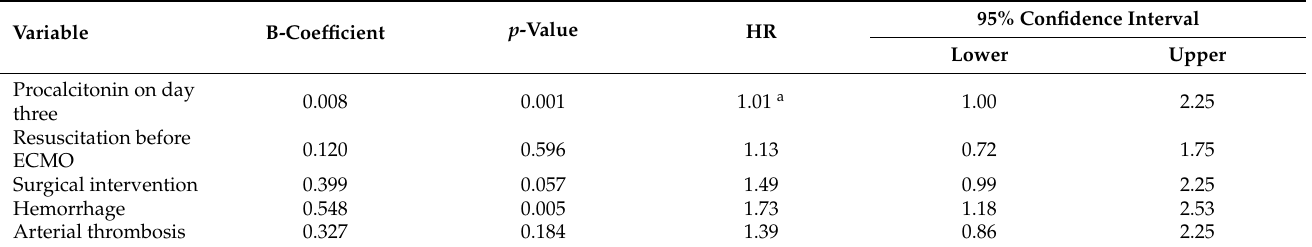
Table 3. Identification of risk factors for death: multivariate analysis ( n =